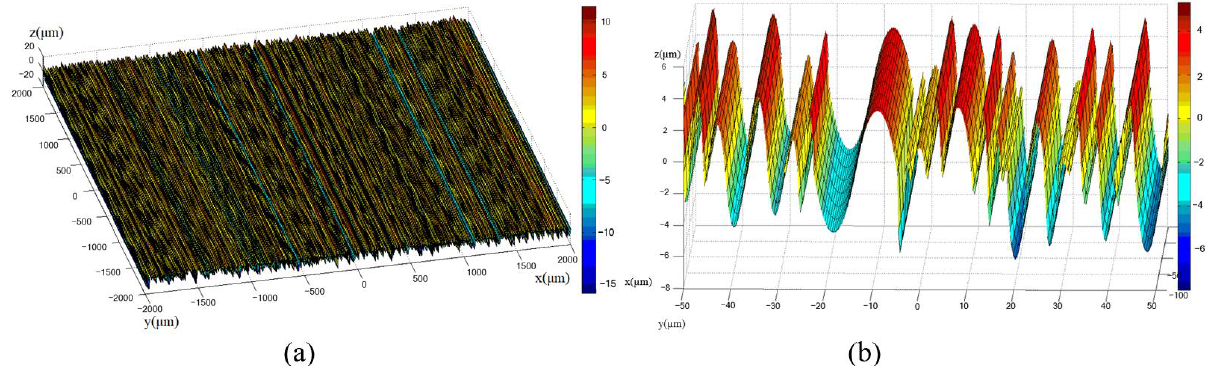
Figure 4. The simulated surface of the workpiece: ( a ) 4000 × 4000 μm, ( b ) in detail.